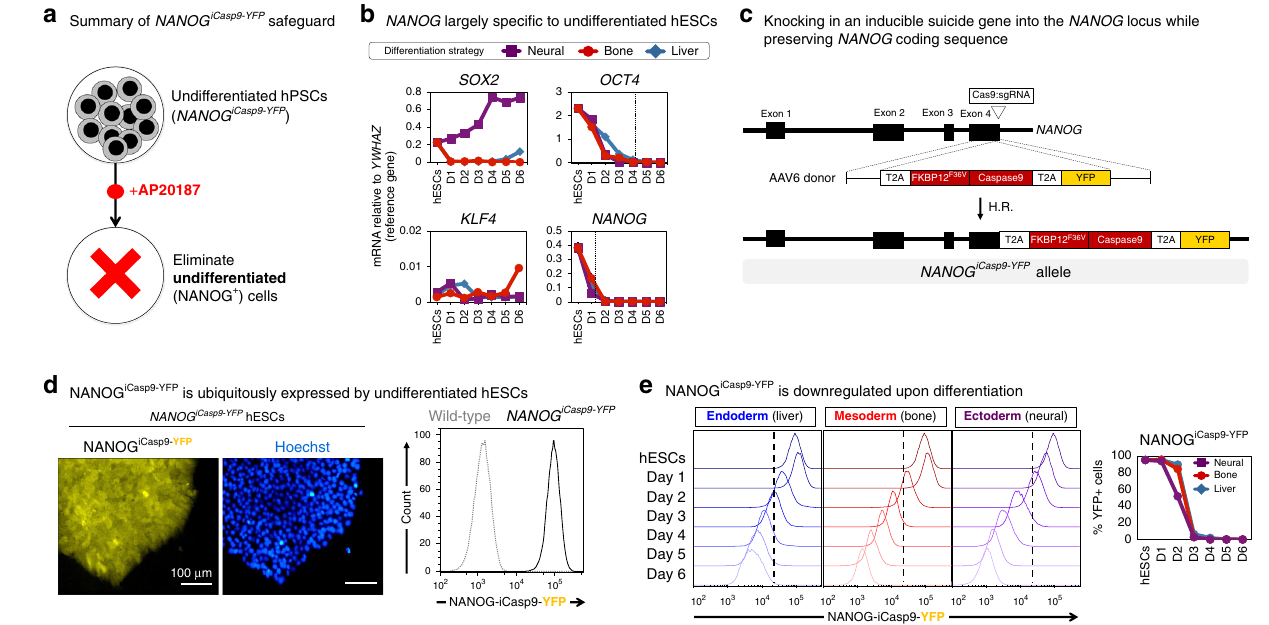
Fig. 2 Rationale and design of the NANOG iCasp9-YFP safety switch. a Intended application of the NANOG iCasp9-YFP safeguard. b Quantitative PCR (qPCR) of pluripotency transcription factor expression during differentiation into endodermal 29,30 , mesodermal 31 , and ectodermal 32 lineages (differentiation was conducted as described in the “ Methods ” ). Dotted line indicates when gene expression declined below 10% of YWHAZ in all three differentiation systems. Expression of lineage markers is depicted normalized to the reference gene YWHAZ (i.e., YWHAZ = 1.0). Error bars = standard error. c Cas9 RNP/AAV6- based strategy for NANOG iCasp9-YFP targeting 38 . d YFP expression levels in NANOG iCasp9-YFP hESCs as shown by epi fl uorescence ( left ) and fl ow cytometry ( right ), relative to wild-type hESCs. Scale bar = 100 μ m. e Flow cytometric analysis of YFP during differentiation of NANOG iCasp9-YFP ; ACTB TK-mPlum hESCs into endodermal, mesodermal, or ectodermal lineages. Dotted line delineates negative vs. positive cells set based on YFP levels in undifferentiated NANOG iCasp9-YFP ; ACTB TK-mPlum hESCs. Error bars = standard deviation. Source data are available in the Source Data fi